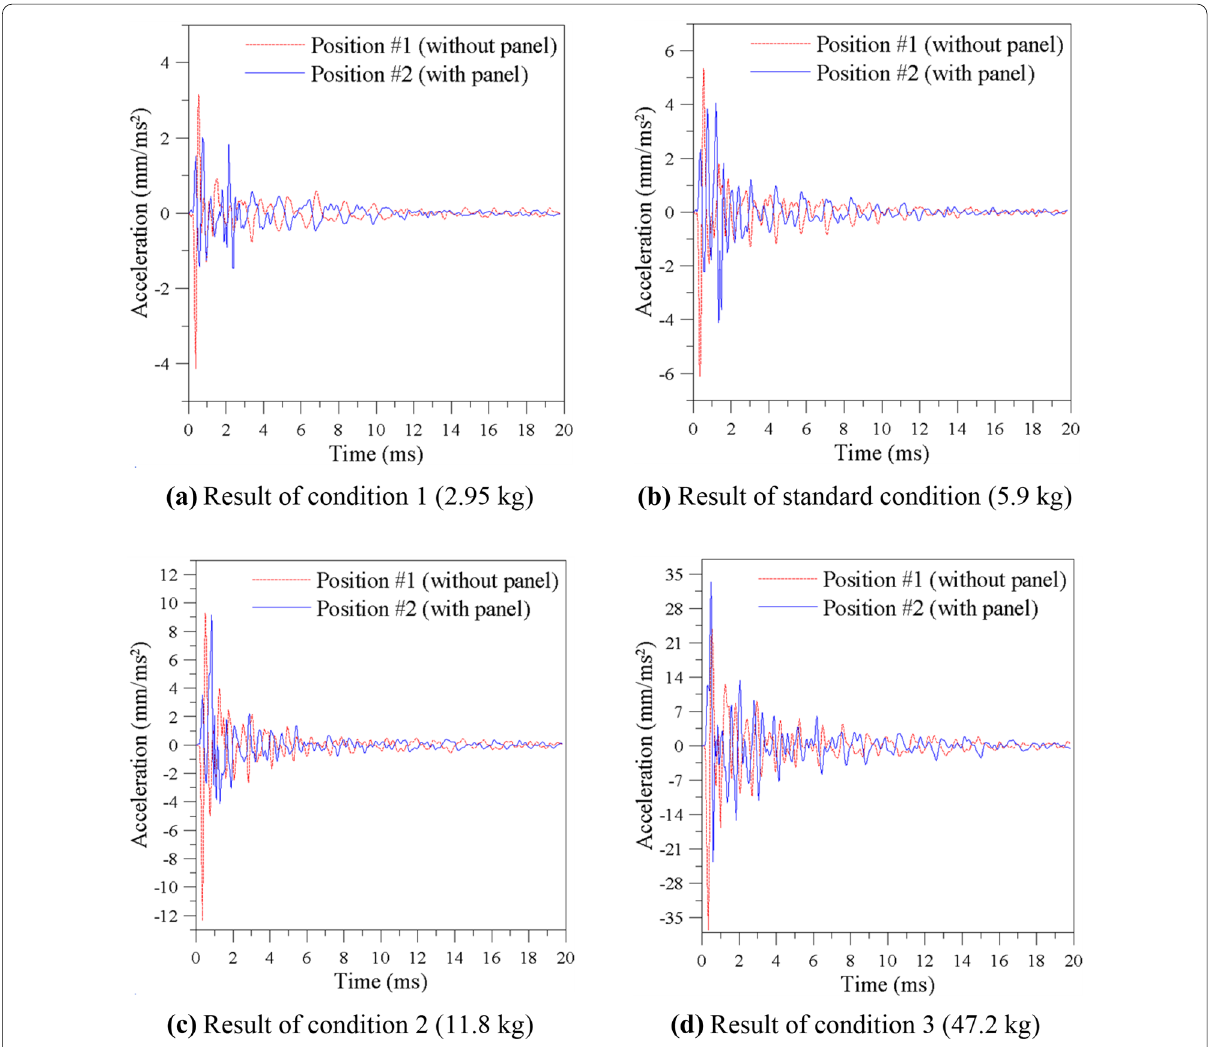
Fig. 15 Acceleration measured at outside wall according to explosion load for normal strength